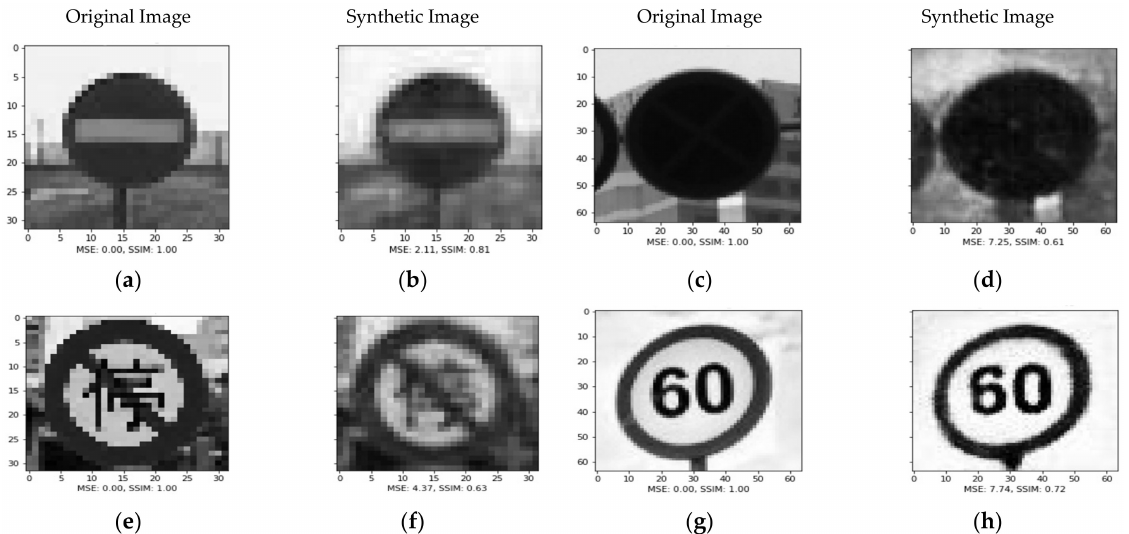
Figure 9. Structural Similarity Index (SSIM) and Mean Squared Error (MSE) Calculation. ( a ). Class T1 Original Image, ( b ) Class T1 Synthetic Image, ( c ). Class T2 Original Image, ( d ) Class T2 Synthetic Image, ( e ). Class T3 Original Image, ( f ) Class T3 Synthetic Image, ( g ). Class T4 Original Image, and ( h ) Class T4 Synthetic